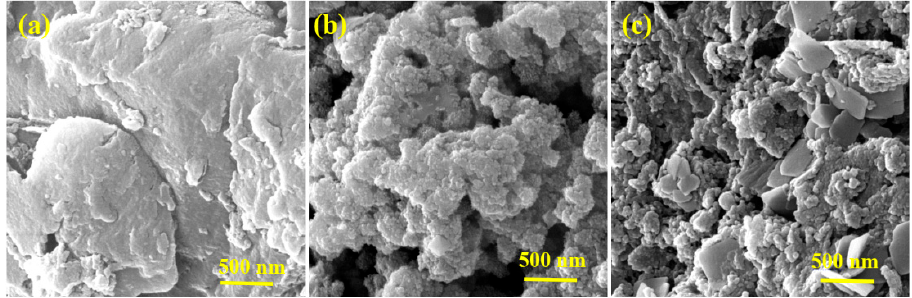
Figure 3. FE-SEM images of pure g-CN ( a ), pure NiO ( b ), and the NiO@g-CN nanocomposite ( c ).